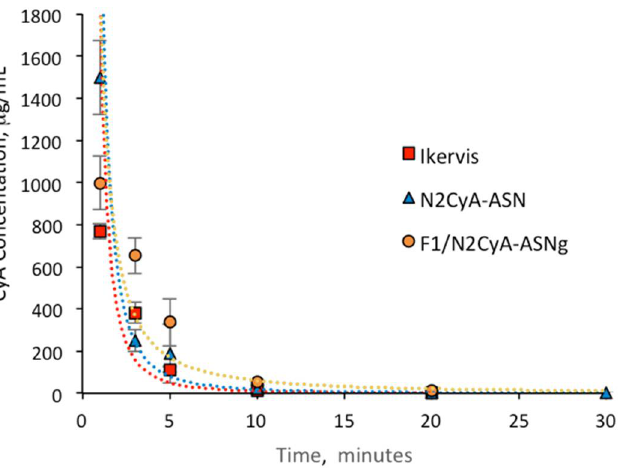
Figure 8. In vivo pharmacokinetics profile of Ikervis ® , N2/CyA-ASN and F1/N2CyA-ASNg ( n = 6, mean ± SE).